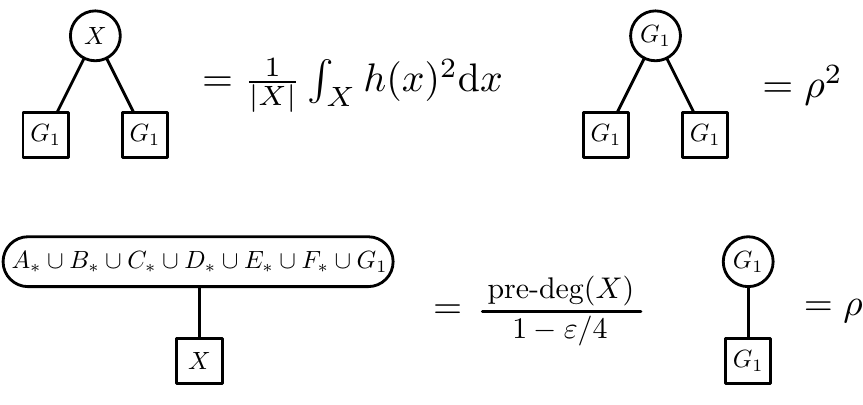
Figure 20: The decorated constraint forcing the structure of the tile A ∗ × B ∗ .